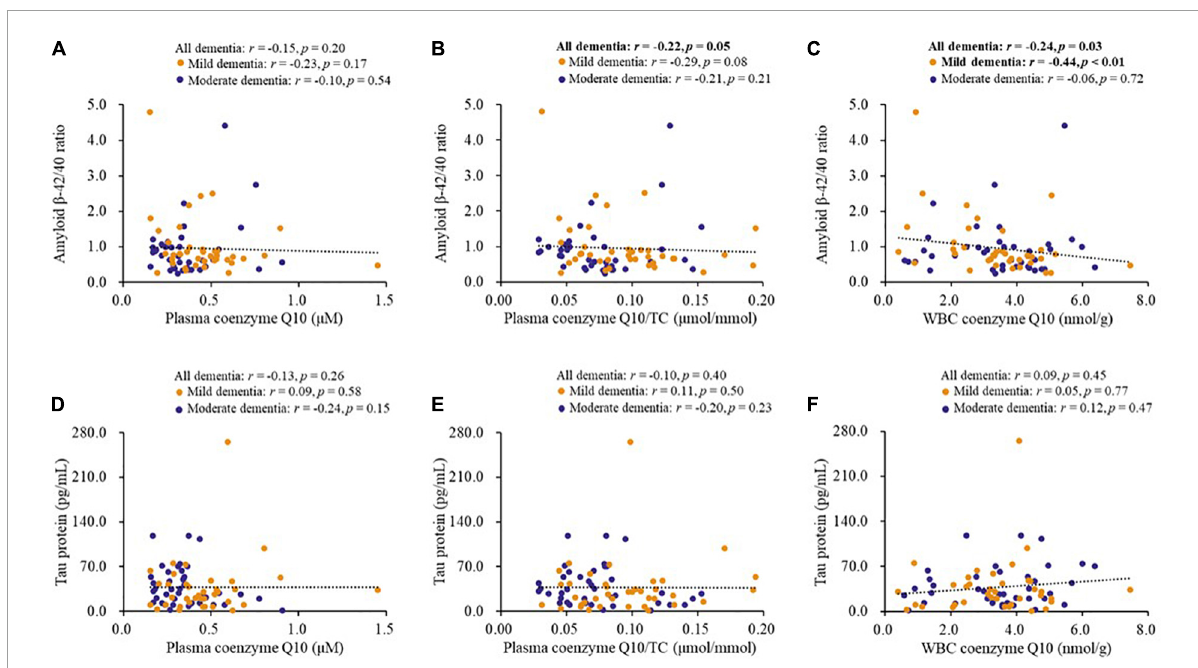
FIGURE3 Correlations between coenzyme Q10 status and biomarkers for dementia of patients. (A–C) Correlations between coenzyme Q10 status and the level of amyloid β -42/40 ratio. (D–F) Correlations between coenzyme Q10 status and the level of tau protein. CoQ10, A β , Tau in Dementia.